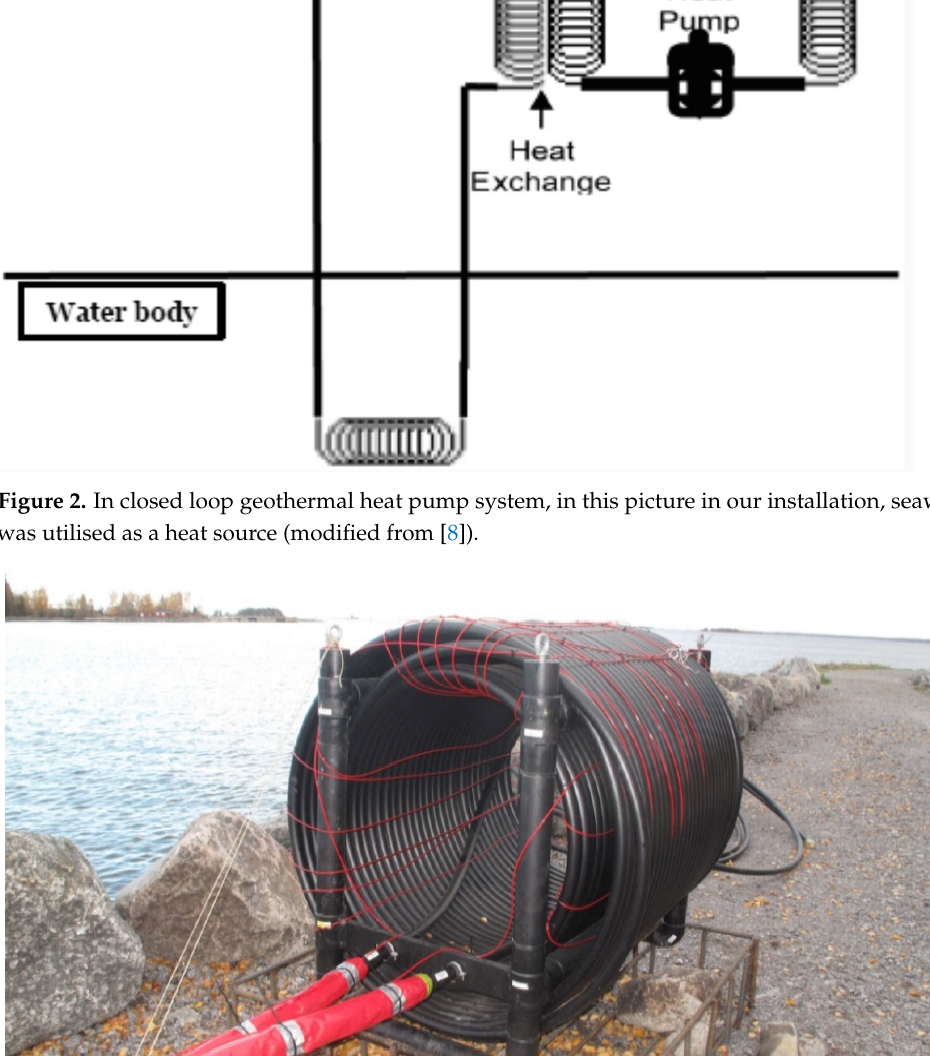
Figure 3. The water heat exchanger that was planned to be installed in Merten Talo is connected to the tubes (of the heat pump in the home), which are insulated. The red wire is the temperature sensors (Picture taken by Anne Mäkiranta during installation process 18 October 2018).